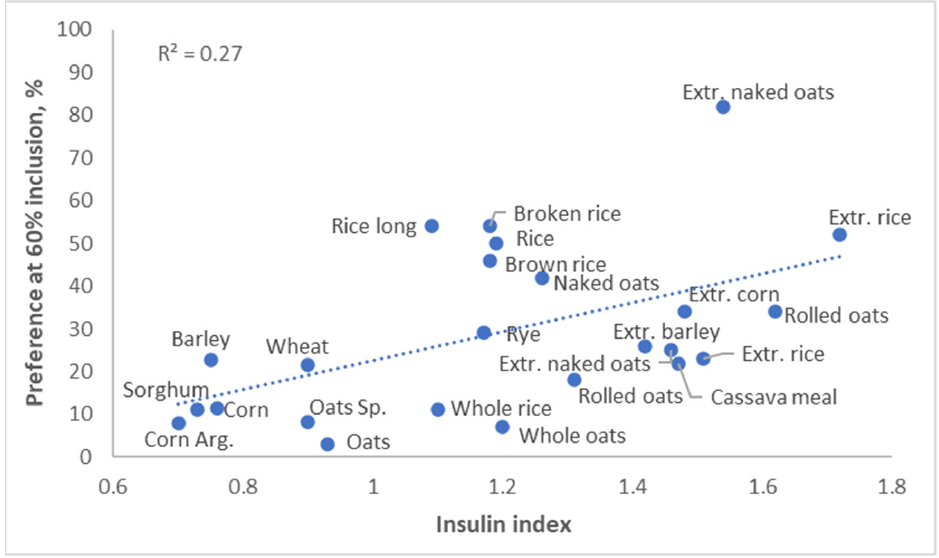
Figure 8. Palatability versus insulin index of a variety of foodstuffs (Solà-Oriol and van Kempen, unpublished).